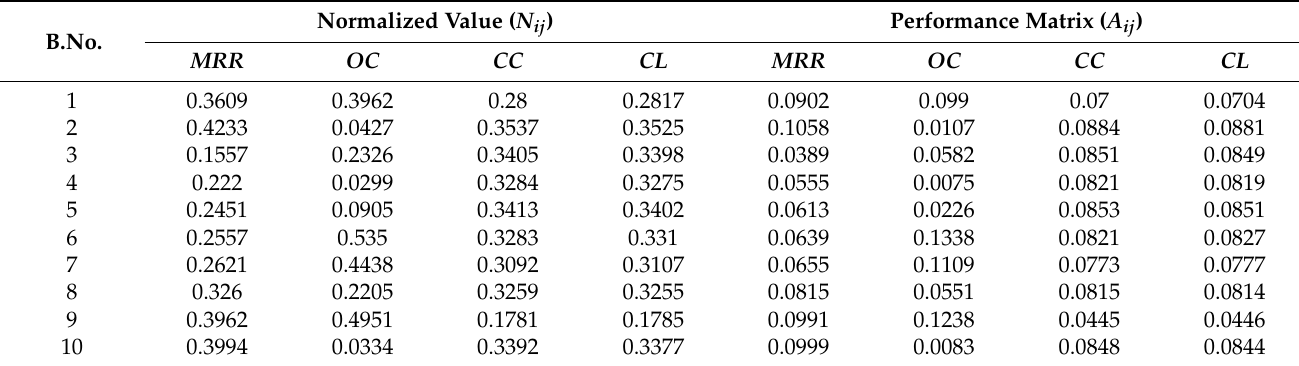
Table A3. Normalized and performance matrix.